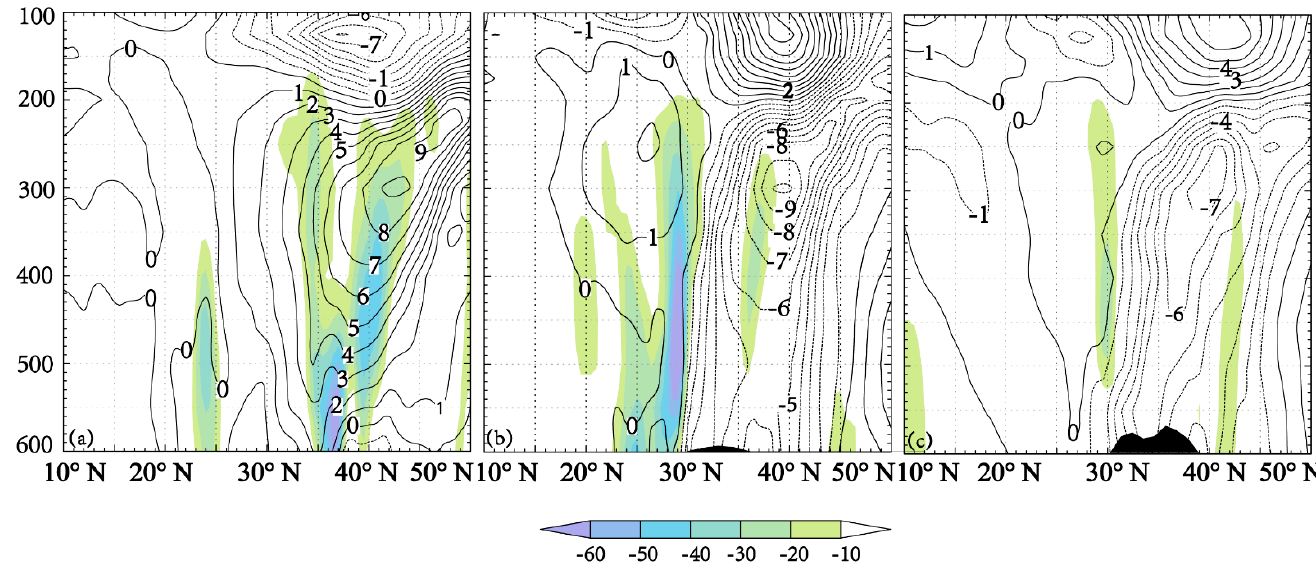
Figure 10. The vertical section of vertical velocity anomalies (shade, units: 10 − 2 Pa/s) and potential temperature anomalies (unit: k) over the Tibetan Plateau for ( a ) the PT-type extreme precipitation event at 100 ◦ E, ( b ) the PSL-type extreme precipitation event at 99 ◦ E, and ( c ) the PV-type extreme precipitation event at 90 ◦ E. The black rectangle on the horizontal axis represents the extreme precipitation area.